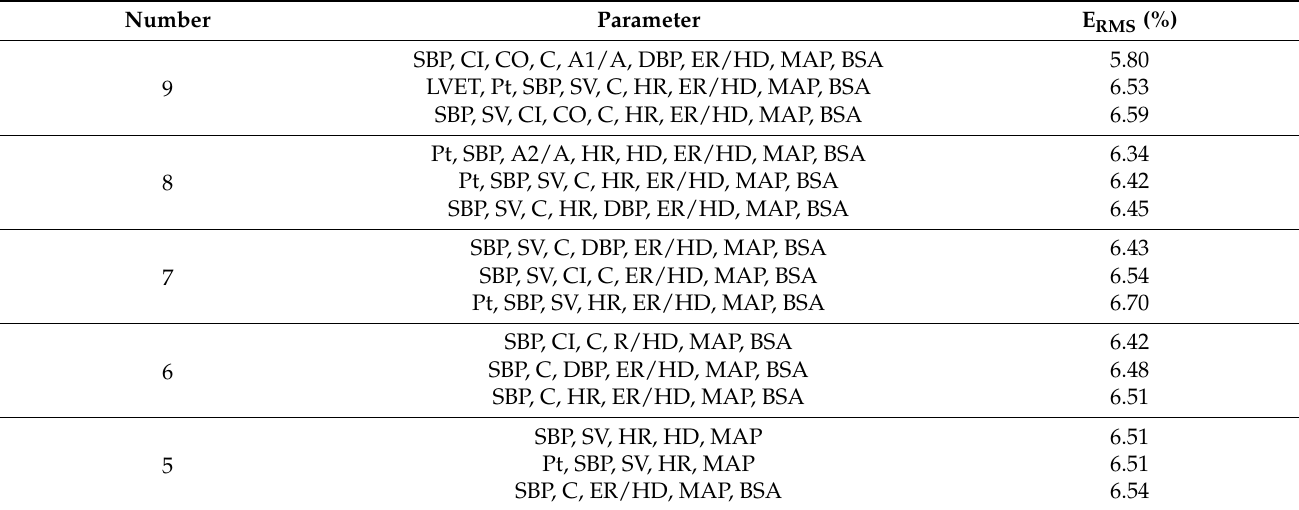
Table 2. The lowest three E RMS under the different number of parameters.